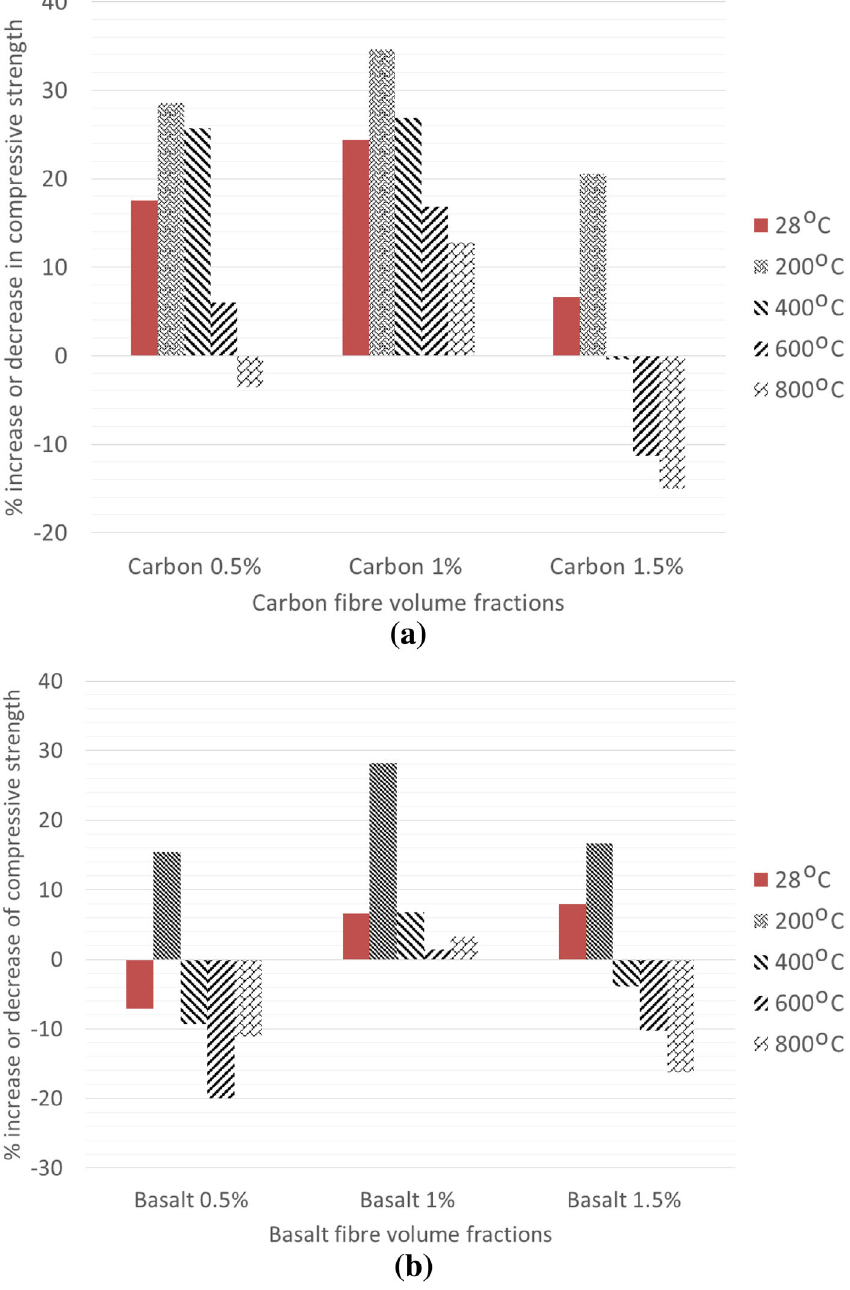
Fig. 7 Percent increase and decrease in compressive strength of geopolymer matrix due to addition of a Carbon fibre reinforced geopolymer composite and b basalt fibre reinforced geopolymer